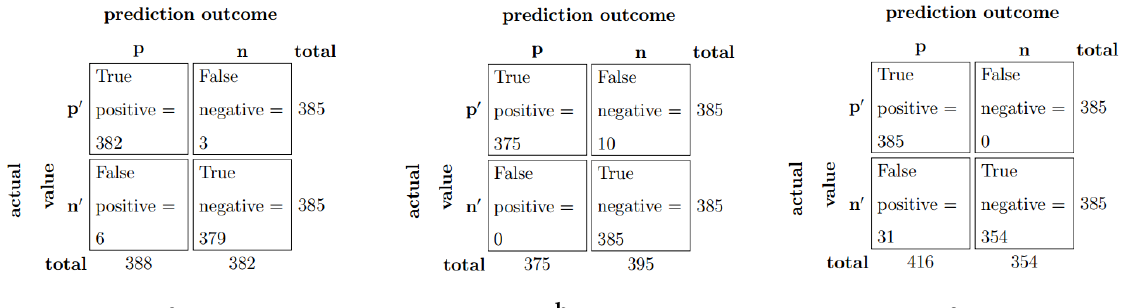
CNN | 2 Figure 6. Both CNN | 1 Scratch and Scratch have a small number of false positives and false negatives in the validation dataset. ( a ) Confusion matrix of CNN | 1 Scratch in the validation dataset. ( b ) Confusion matrix of CNN | 2 Scratch in the validation dataset. ( c ) Confusion matrix of CNN | Xfer in the validation